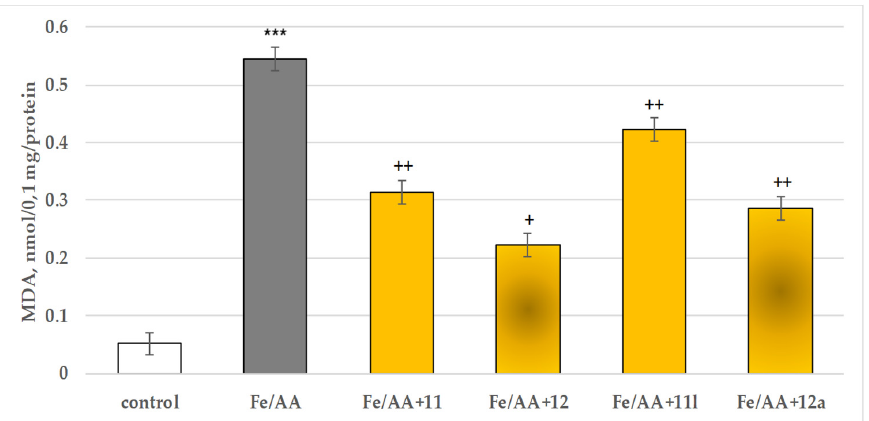
Figure 11. Effects of 11 , 11l, 12 and 12a in a model of non ‐ enzymatic induced lipid peroxidation on MDA production in isolated rat brain microsomes. *** p < 0.001 against the control (untreated microsomes), + p < 0.05; ++ p < 0.01 against Fe 2+ /AA.